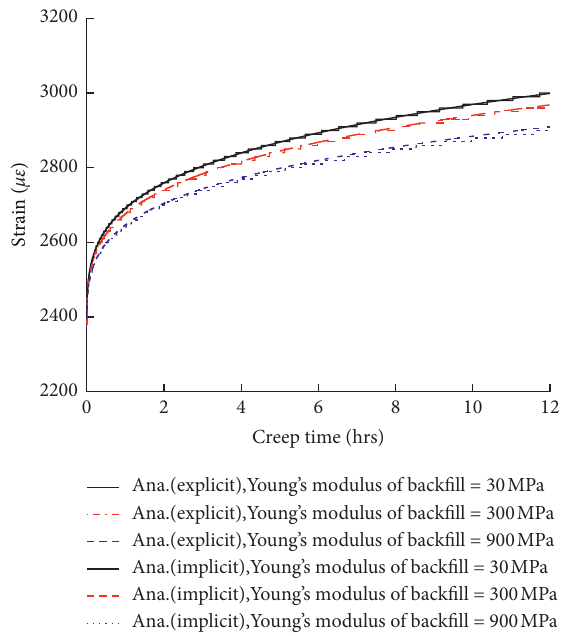
Figure 4: Results of coupled implicit solution and uncoupled explicit